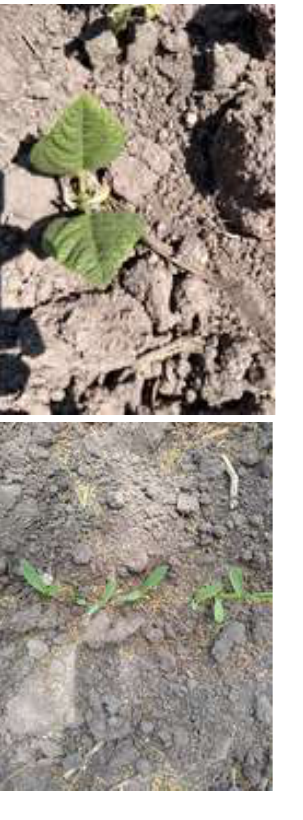
13 of 23 Table 6. Example of the database structure for combination C1. Cultivation Type Dates of Images or Scenes Included in the Database corn 1